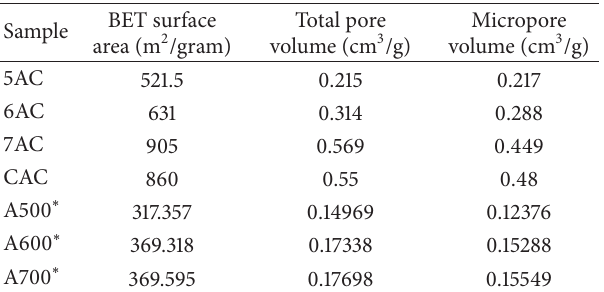
Table 2: BET surface area and pore volume of palm shell activated carbon.